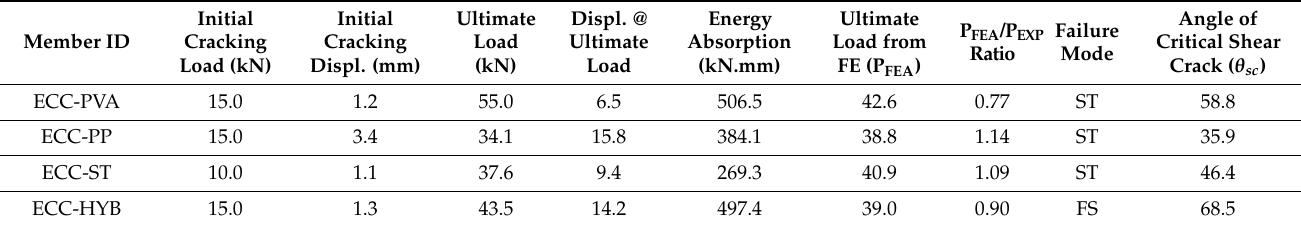
Table 3. Summary of test results.